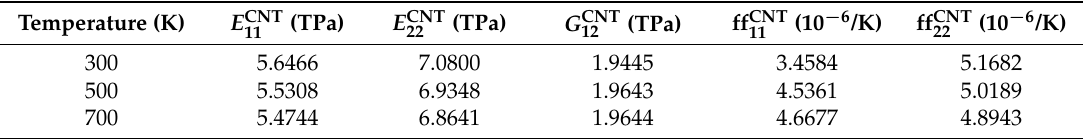
Table 1. Temperature-dependent material properties of (10, 10) SWCNT (L = 9.26 nm, R = 0.68 nm, = h = 0.067 nm, ρ CNT 12